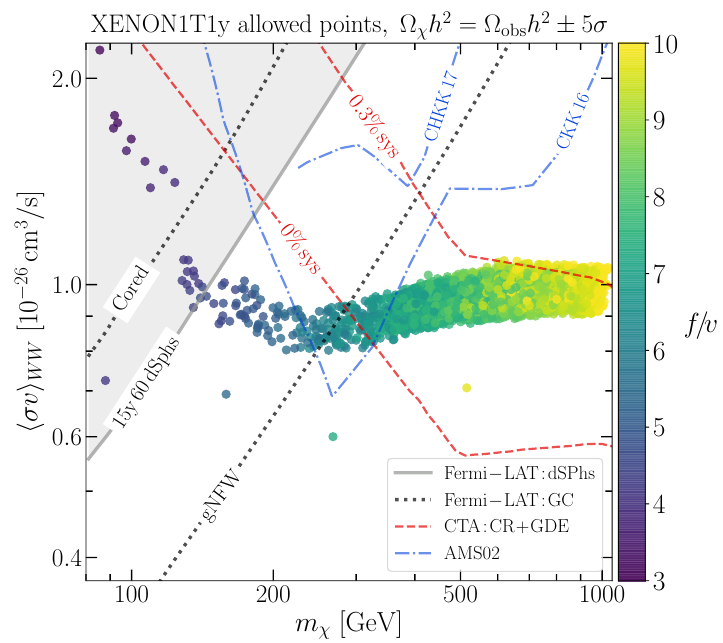
Figure 13 . A parameter scan with all the points producing correct relic abundance in the m (cid:31) vs . Each point (color coded for di(cid:11)erent f=v values) is allowed by the XENON1T1y direct (cid:27)v h i WW detection experiment. The gray shaded region is the robust projected 95% C.L. sensitivity of Fermi-LAT with 15 years data and 60 dSphs. The dashed curves represents the CTA projected 95% C.L. sensitivity with background only (0% systematics) and 0.3% systematics, whereas the dotted and dash-dotted curves are relatively less robust 95% C.L. upper bounds due to Fermi-LAT and AMS-02 ,